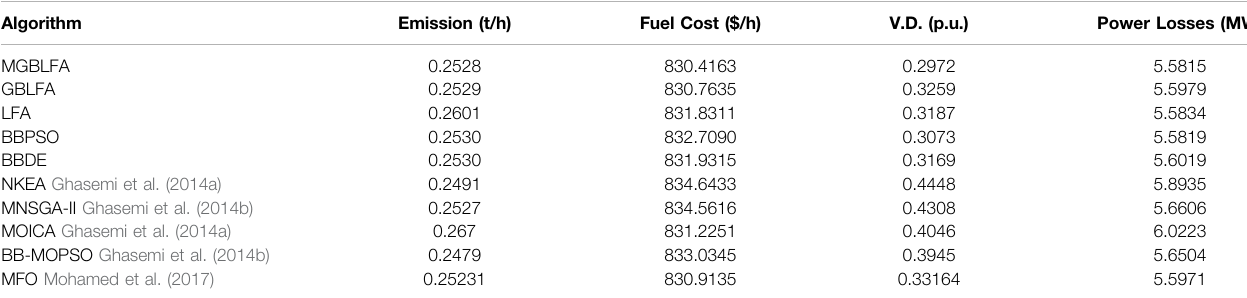
TABLE 9 | Comparison of optimal results by algorithms for Case 8.